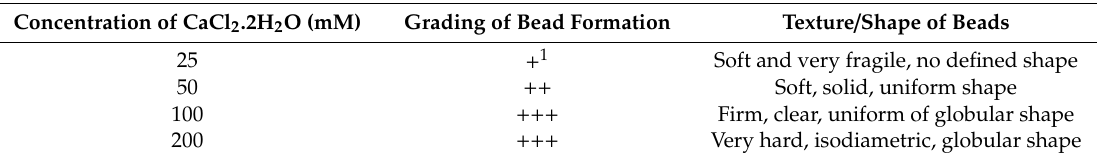
Table 3. Influence of di ff erent concentrations of calcium chloride (CaCl 2 .2H 2 O), mixed with 2.5% sodium alginate, on the type of bead formation of V. dentatum .